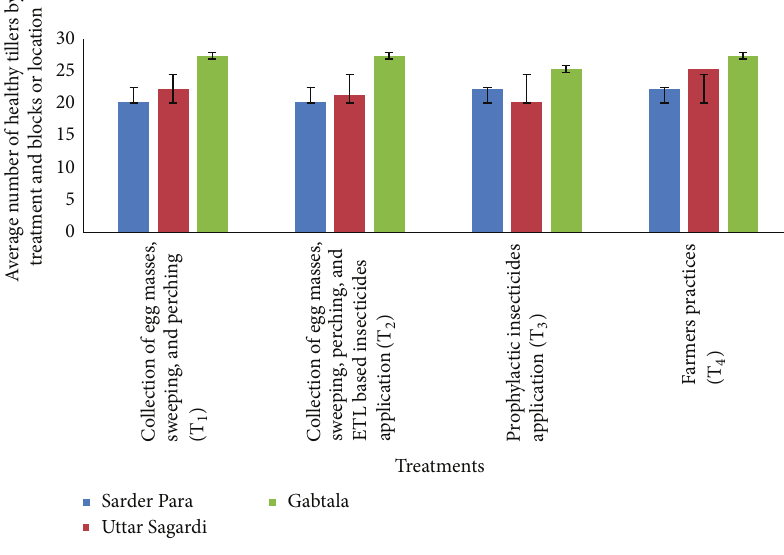
Figure 1: Outline of the different treatments.